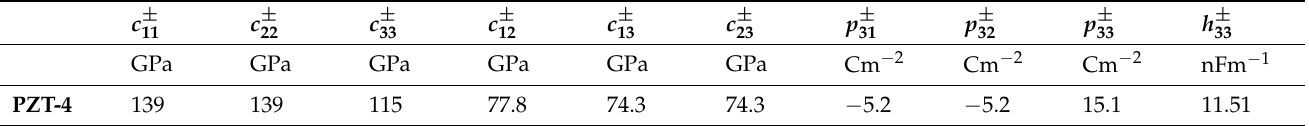
Table 1. Constitutive coefficients of the adherents [55].